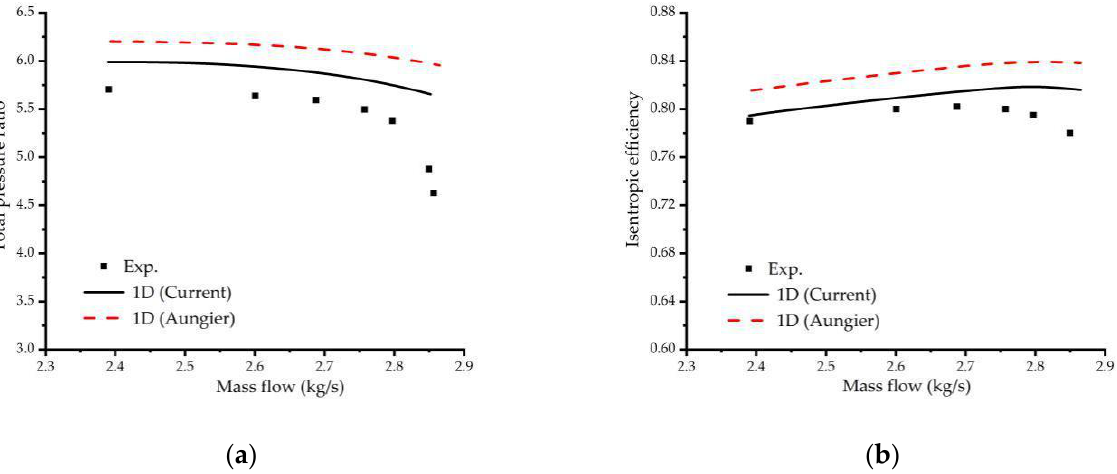
Figure 5. Performance comparison for: ( a ) Krain impeller; ( b ) Eckardt-O impeller.